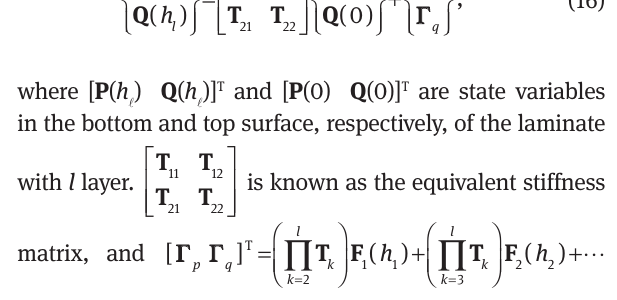
is the equivalent external load vector.